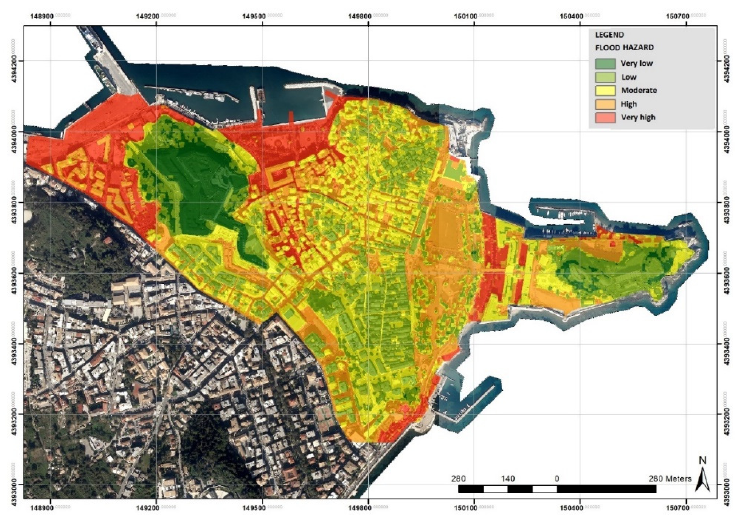
Figure 17. Flood hazard map for the maximum rain rate of the climate scenario (2031–2060, RCP 8.5).